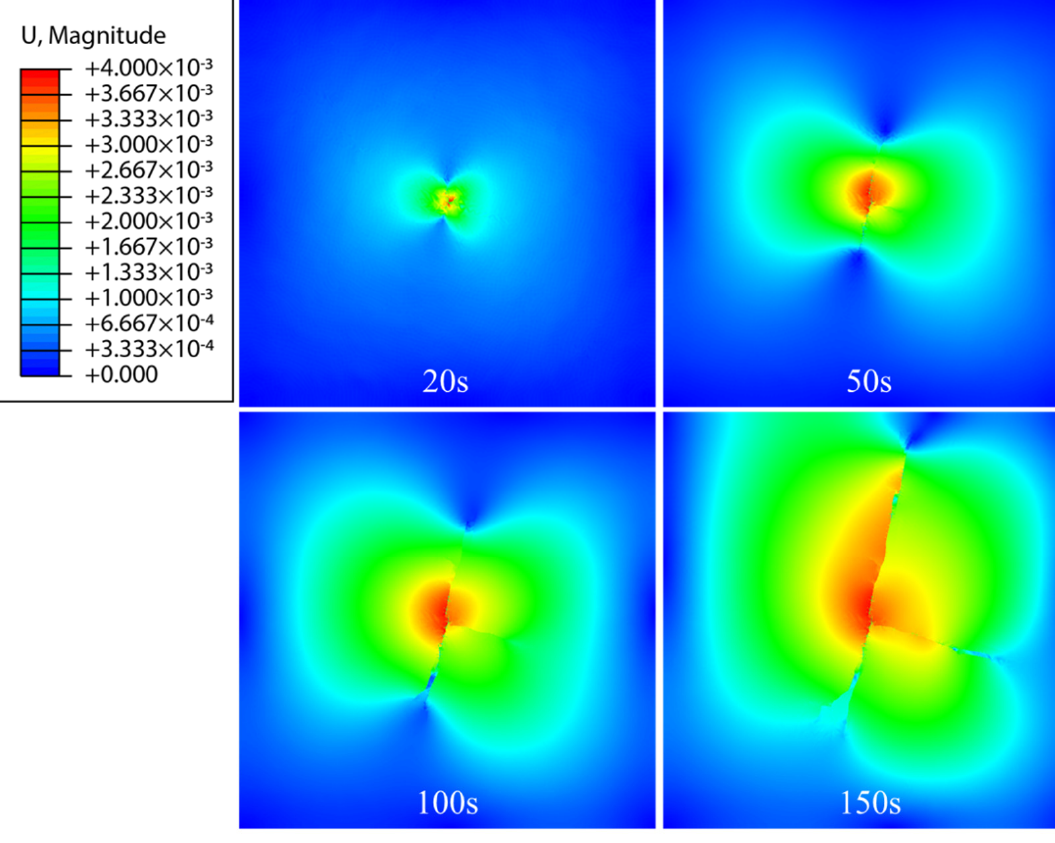
Figure 5. Displacement contour plot of the natural fracture network of group A at different moments under a stress difference of 0